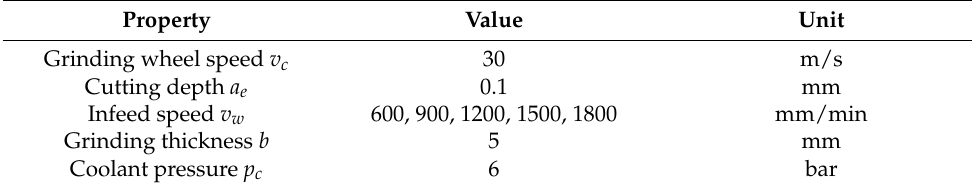
Table 4. Grinding Parameters.